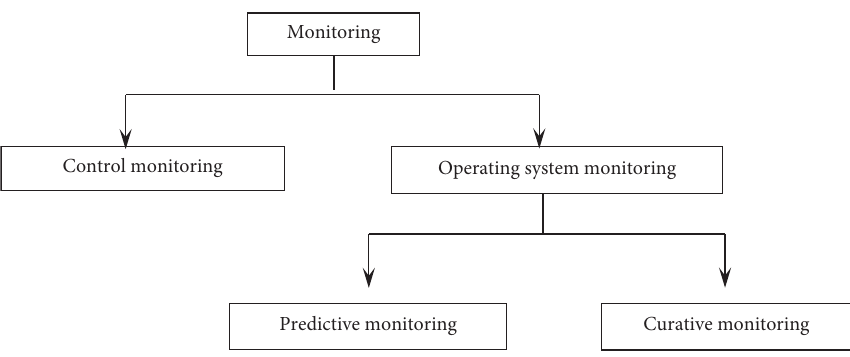
Figure 11: Monitoring types.